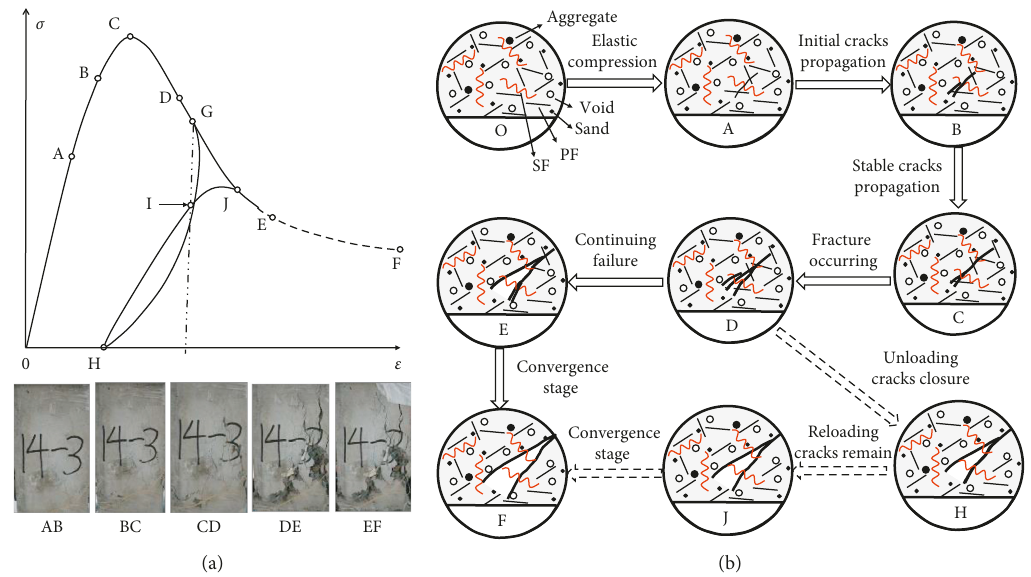
Figure 7: Ideal schematic of cyclic compressive process of BFRC specimen. (a) Schematic of stress-strain curve and the corresponding morphologies of typical specimen surface for each loading stage. (b) The schematic drawing showing propagation of a